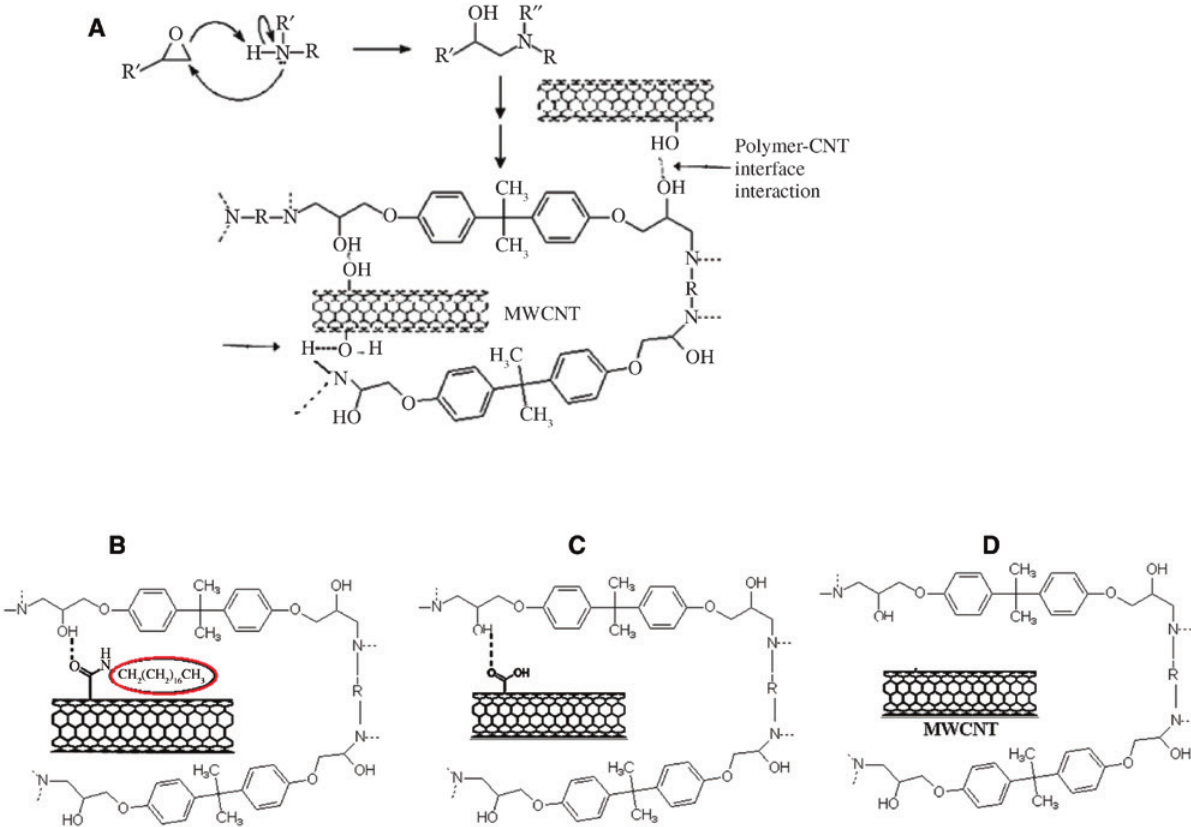
Figure 7: Interactions of the CNTs with epoxy and TETA. (A) CNT-OH; (B) CNT-ODA; (C) CNT-COOH, and (D) raw CNTs (no specific interactions).